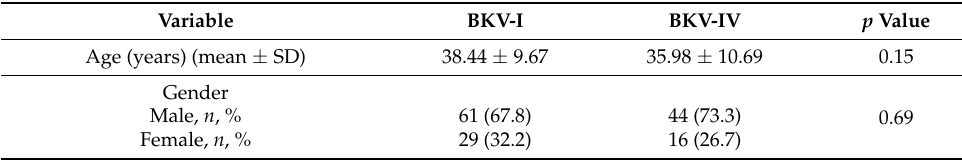
Table 5. Comparison between BKV-I and BKV-IV